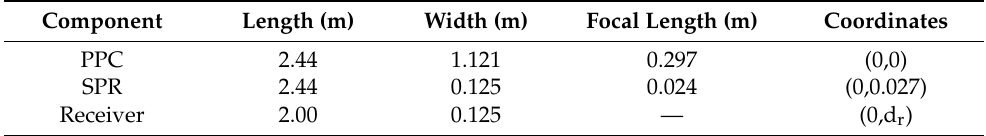
Table 1. Initial geometrical and optical parameters of the linear Cassegrain-type thermal photovoltaic concentrator. Component